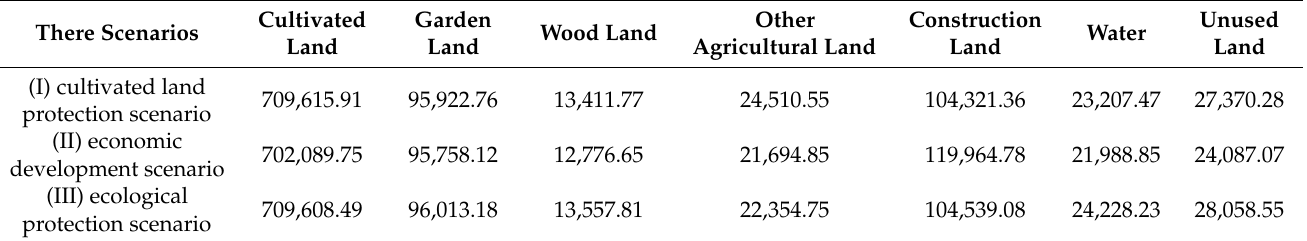
Table 5. The land use demand in three scenarios of Suzhou in 2028 (hm 2